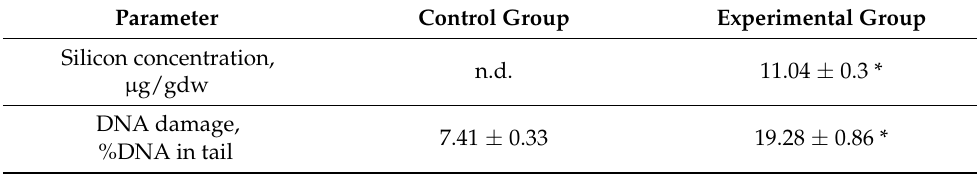
Table 2. Si concentration and DNA damage level in digestive gland cells of experimental and control mussels (mean ± standard deviation). n.d.—not detected. * Difference from the control is significant ( p <